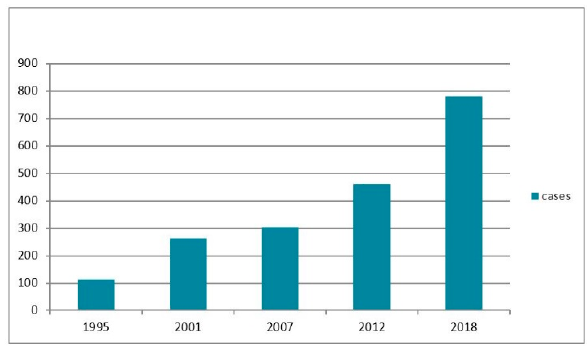
Figure 1. Dynamics of dirofilariasis cases, 1995–2018,